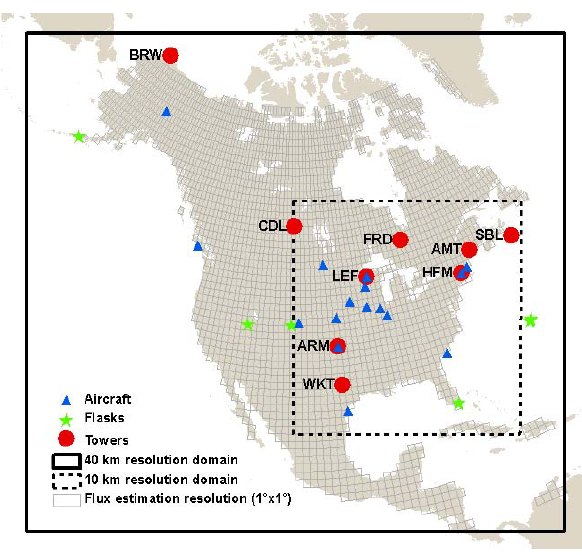
Fig. 1. Domains of nested WRF winds, flux estimation grid, and the locations of towers, flask and aircraft measurements used in the inversions. See Table A1 in the Supplement for a key to the tower